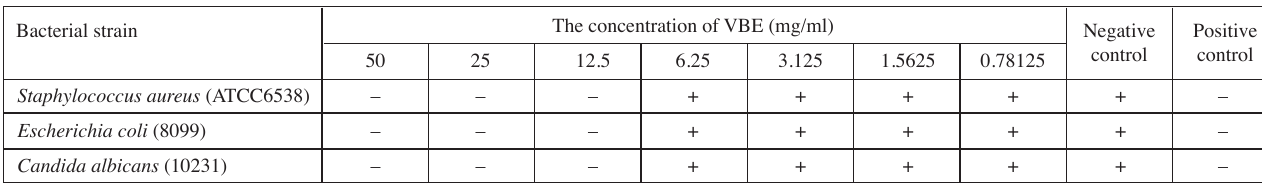
The concentration of VBE